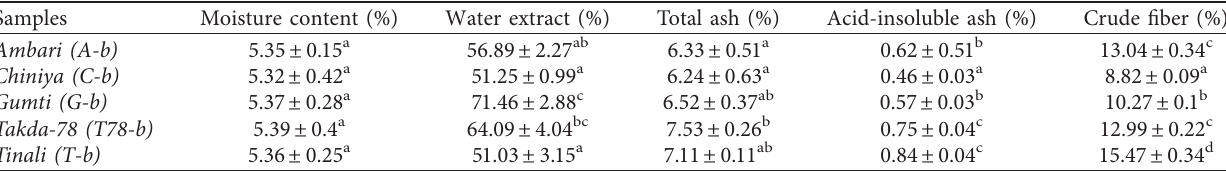
Table 2: Moisture content, water extract, total ash, acid-insoluble ash, and the fiber content of black tea prepared from different clones of tea